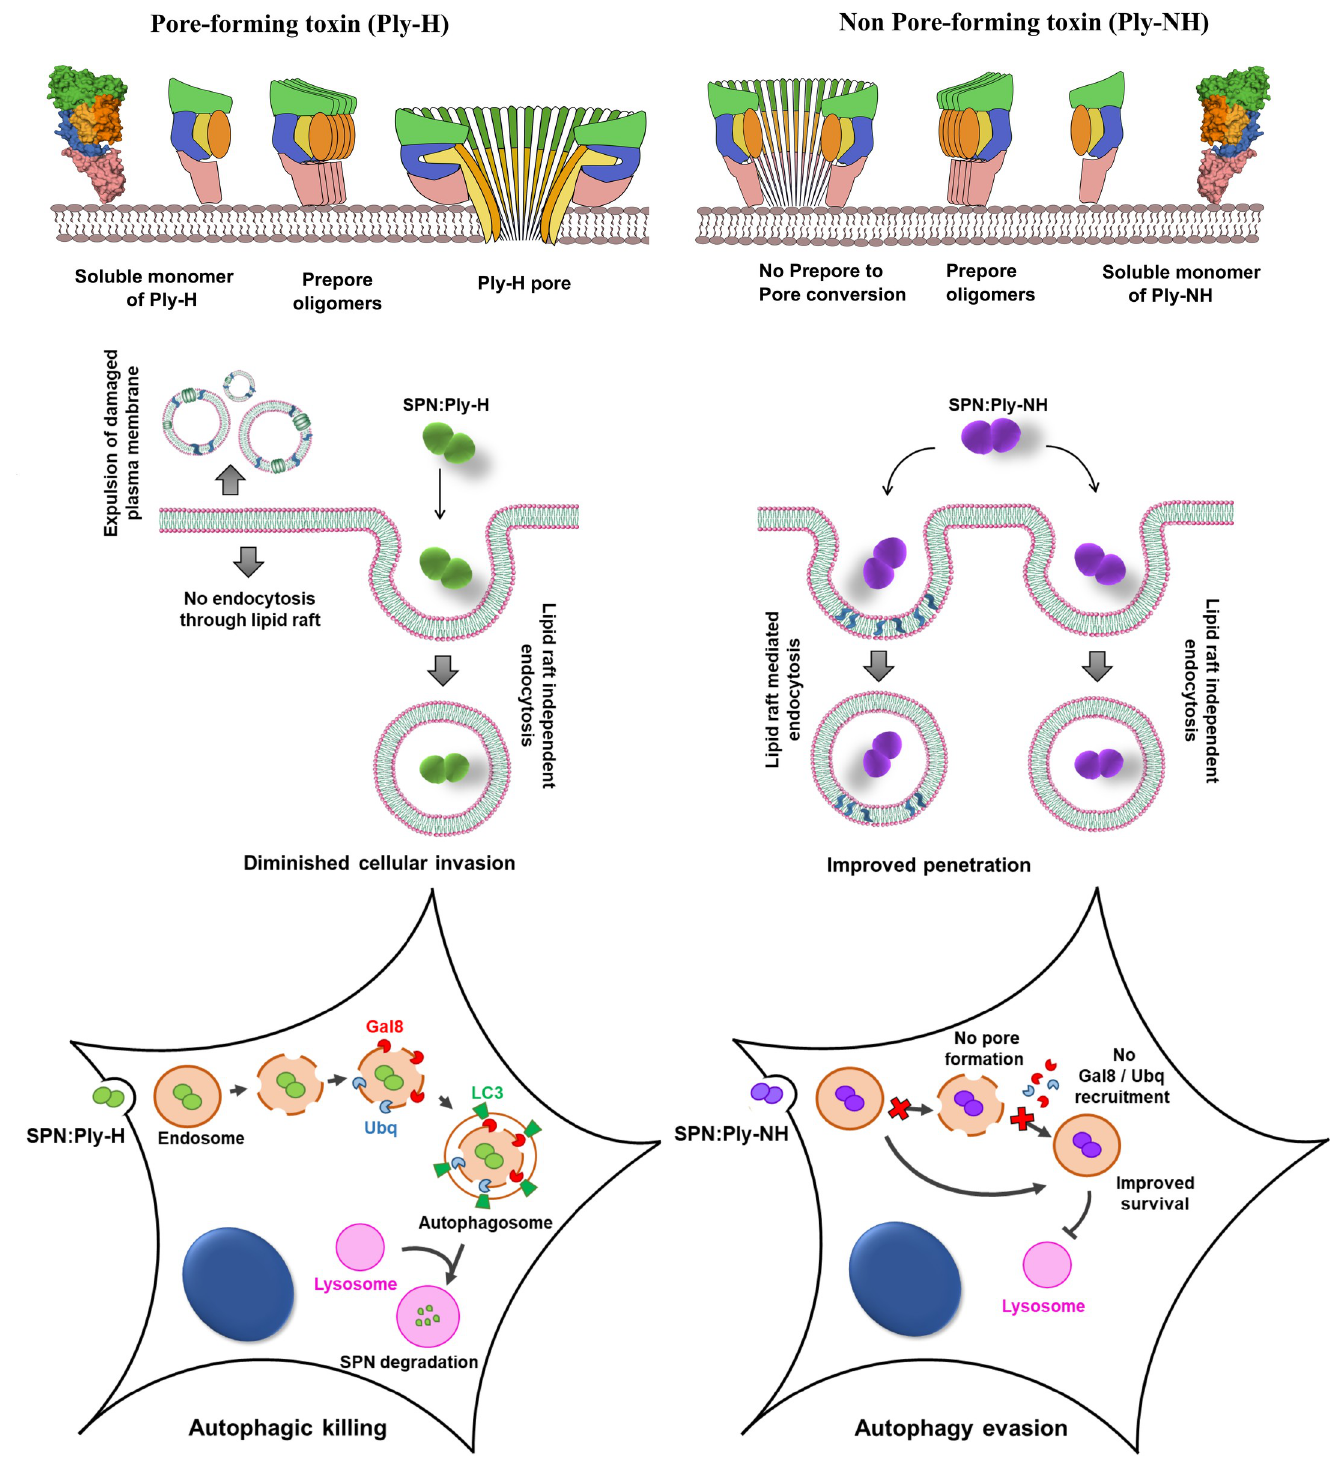
Fig 7. Schematic of pore formation by Ply variants and its role in pneumococcal lifestyle. Cartoon representation of major stages of pore formation by Ply-H and Ply-NH and their contribution to cellular uptake and intracellular fate of SPN.